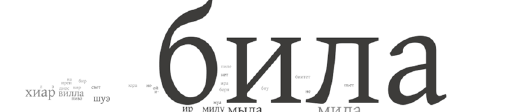
Figure 7: Utterance miss (false negative error) for utterances in Russian against pink noise: comparison of male and female voices.